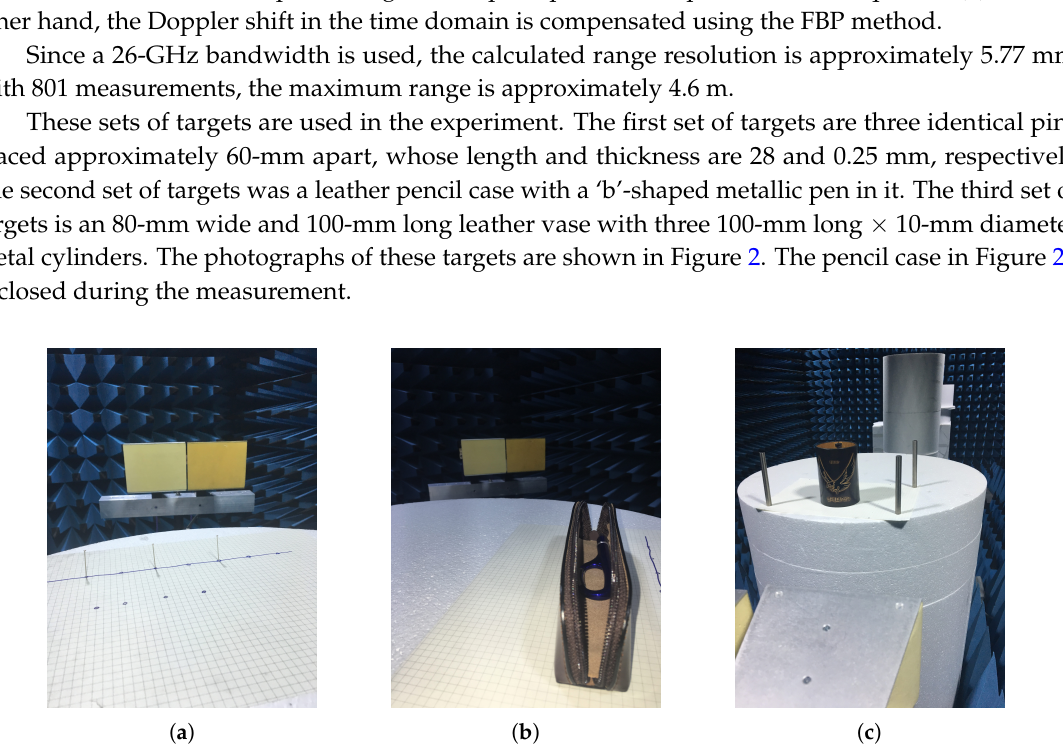
Figure 2. The targets for radar imaging; ( a ) pins; ( b ) “ b ”-shaped metal pen inside a pencil case; and ( c ) cylindrical pencil vase with three metal cylinders.